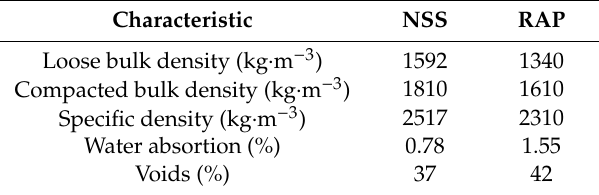
Table 4. Physical properties of used aggregate types.